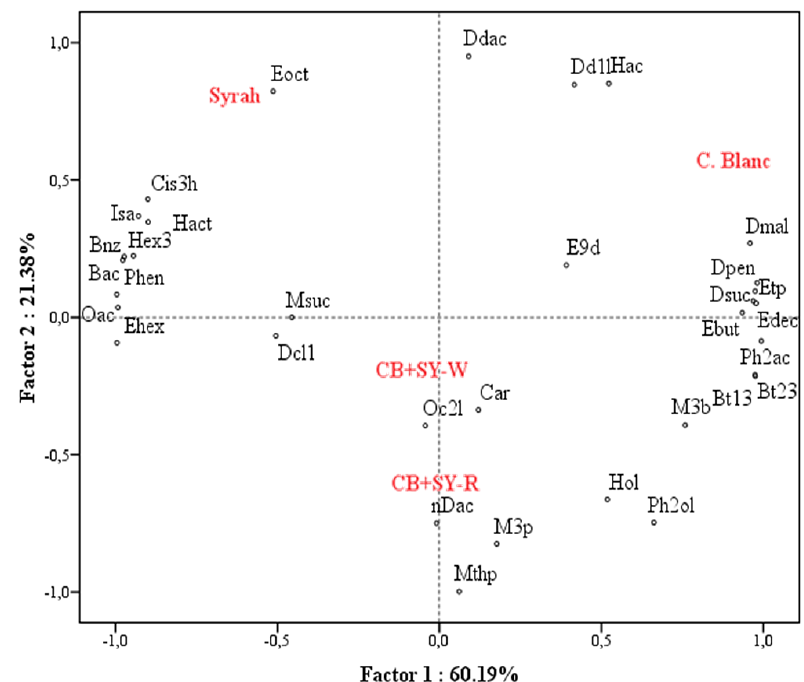
Figure 1. Principal component analysis (PCA) performed with results of volatile compounds identified in the sparkling wines produced by the traditional method in the SFV from Chenin Blanc and Syrah varieties. Legend: Carvone (Car), 3-Methyl-1-butanol (M3b), 3-methyl-1-pentanol (M3p), hexan-1-ol (Hol), 3-ethoxypropan-1-ol (Etp), ( Z )-3-hexen-1-ol (Hex3), octan-2-ol (Oc2l), 2,3-Butanediol (Bt23), 1,3-butanediol (Bt13), decan-1-ol (Dcl1), 2-phenylethanol (Ph2ol), dodecan-1-ol (Dd1l), ethyl butanoate (Ebut), ethyl hexanoate (Ehex), ethyl octanoate (Eoct), ethyl decanoate (Edec), diethyl succinate (Dsuc), ethyl 9-decenoate (E9d), diethyl pentanedioate (Dpen), 2-phenylethyl acetate (Ph2ac), diethyl malate (Dmal), monoethyl succinate (Msuc), isoamyl acetate (Isa), hexyl acetate (Hact), cis -3-hexen-1-ol acetate (Cis3h), butanoic acid (Bac), hexanoic acid (Hac), octanoic acid (Oac), n -decanoic acid (nDac), dodecanoic acid (Ddac), 3-(methylthio)-1-propanol (Mthp), benzaldehyde (Bnz), and phenol (Phen). Sparkling wine 50% Chenin Blanc and 50% Syrah, elaborated as white (CB+SY-B), sparkling wine 50% Chenin Blanc and 50% Syrah, elaborated as rosé (CB+SY-R).